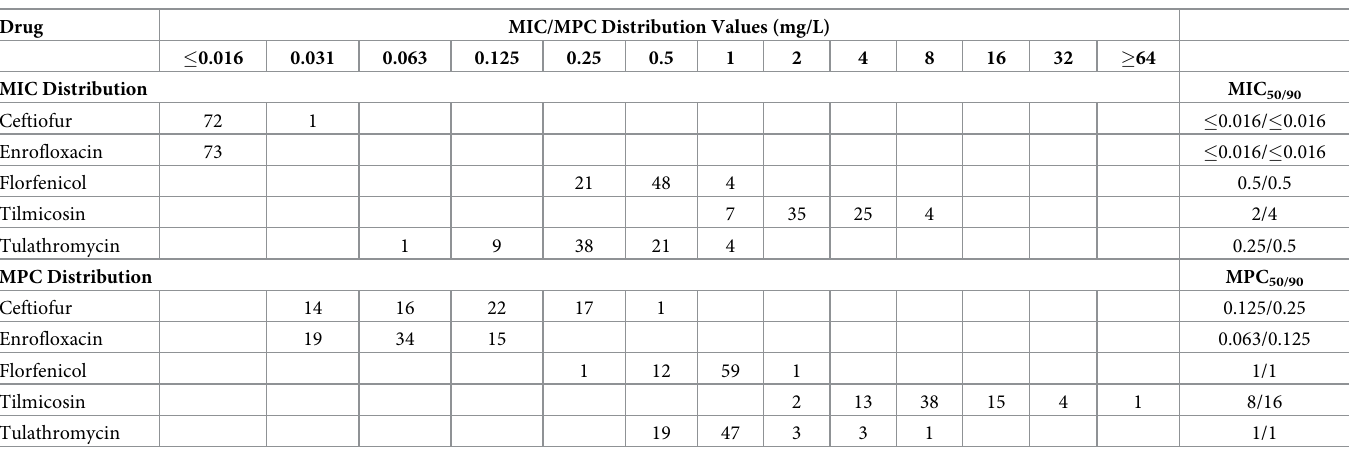
Table 2. MIC and MPC values for 73 P . multocida isolates from swine.